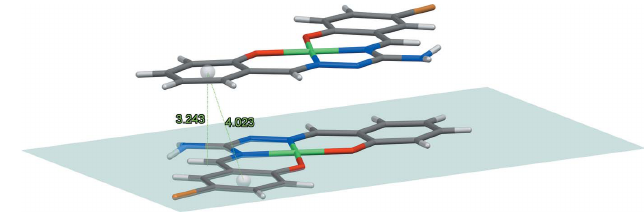
Figure 1 Molecular structure and atom labelling of [Ni L ] (cid:2) C 3 H 7 NO (cid:2) H 2 O (I), with displacement ellipsoids at the 50% probability